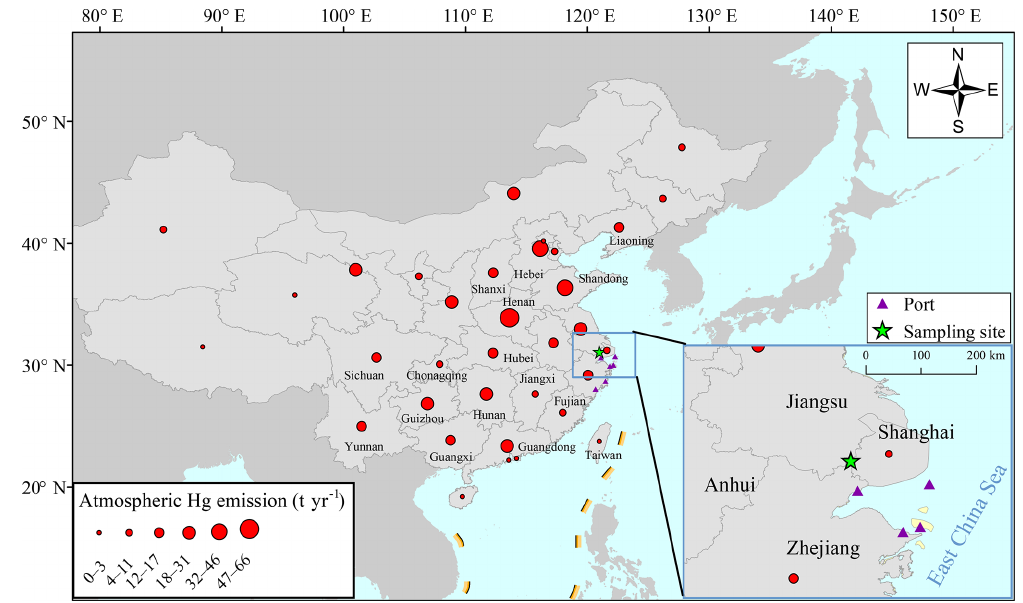
Figure 1. The location of the Dianshan Lake (DSL) site in Shanghai, China. The red dots in the map represent the anthropogenic atmospheric Hg emissions by each province in 2014 (Wu et al.,